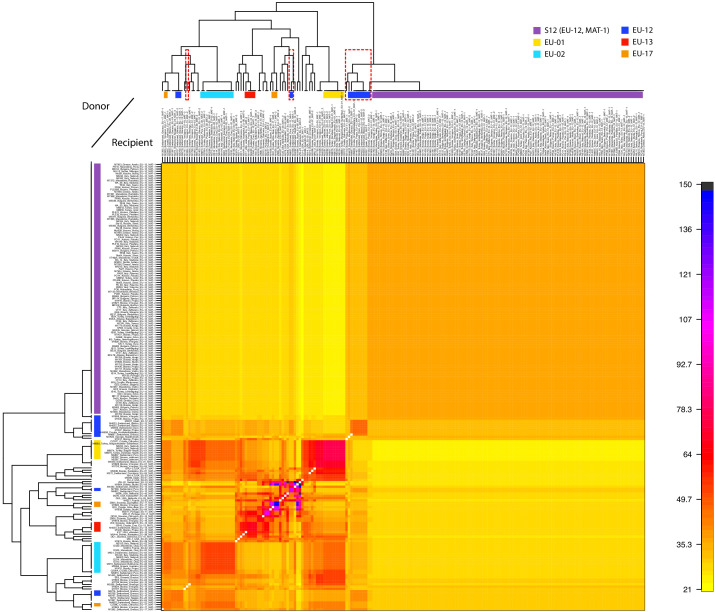
Full averaged coancestry matrix showing isolate identifiers.